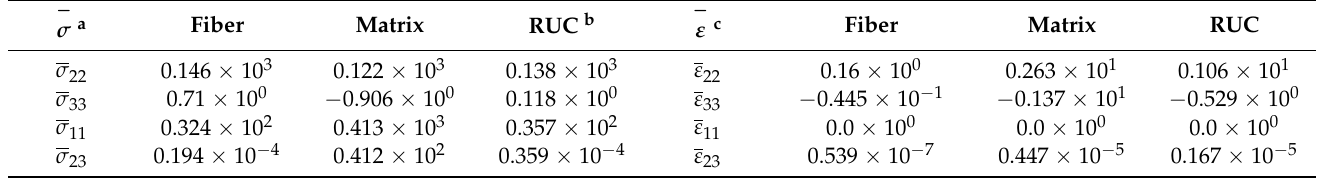
Table 1. Average values of stress and strain (Case 1).